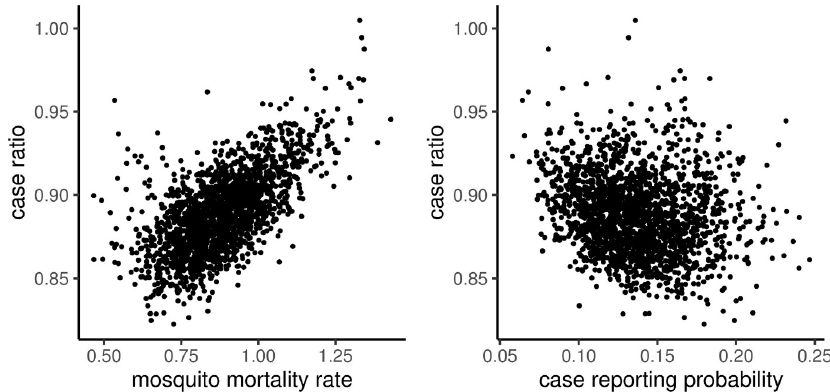
Fig 4. Posterior correlation between system parameters and the effectiveness of control. The y-axis represents the effectiveness of optimally timed control, i.e., the effect of control implmented in the 34th week of the year on the relative number of cases in the following year, summed over 2008, 2009, and 2010. Each point represets a single sample from the posterior distribution, giving the number of cases in the controlled simulation (relative to the number of cases expected without control) as a function of A: the mean mosquito mortality rate, d 0 , and B: the case reporting probability, ϕ , from that posterior sample.